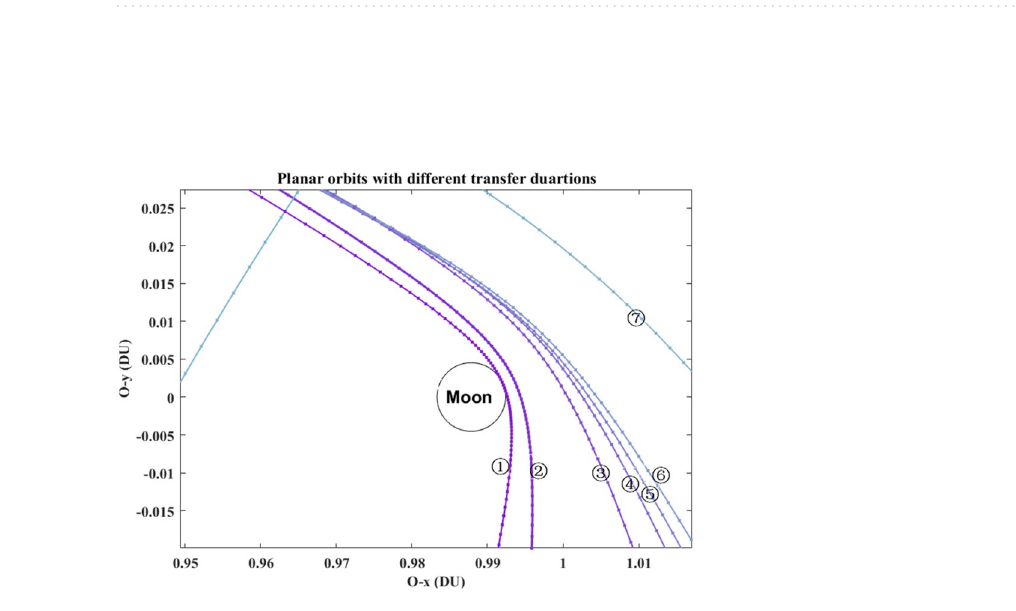
Figure 11. The detail paths in the Moon